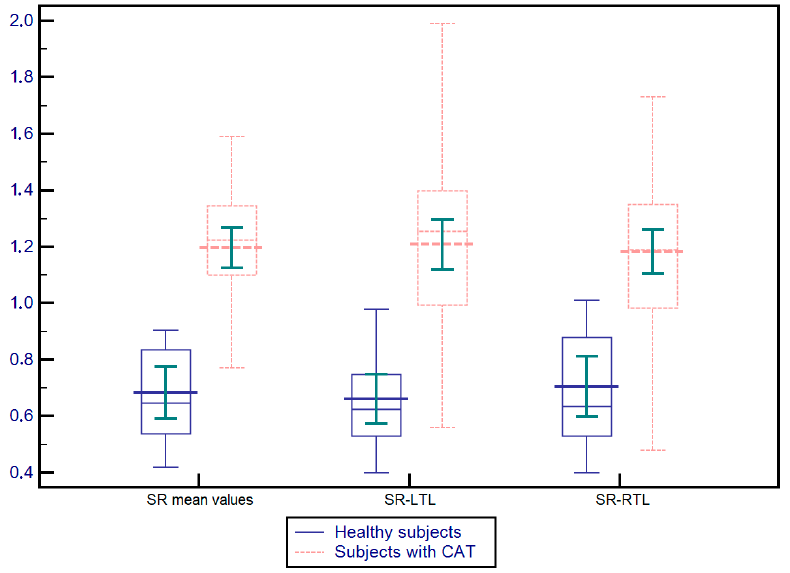
Figure 3. Box-and-whisker distribution plots comparing SR mean values, SR-LTL, and SR-RTL, respectively in the two subgroups (healthy subjects vs. subjects with CAT). The mean thyroid stiffness (TS) values were significantly higher for children with CAT compared to the healthy controls (1.19 ± 0.25 vs. 0.68 ± 0.2; p < 0.0001) (Table